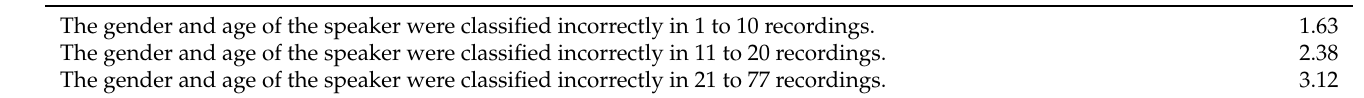
Table 5. The average number of digits in the recordings when the gender and age of the speaker were classified